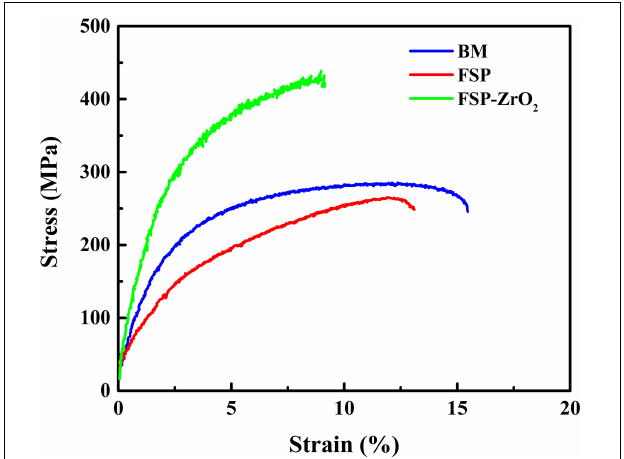
FIGURE 9 | The stress-strain curves of BM, FSP and FSP-ZrO 2